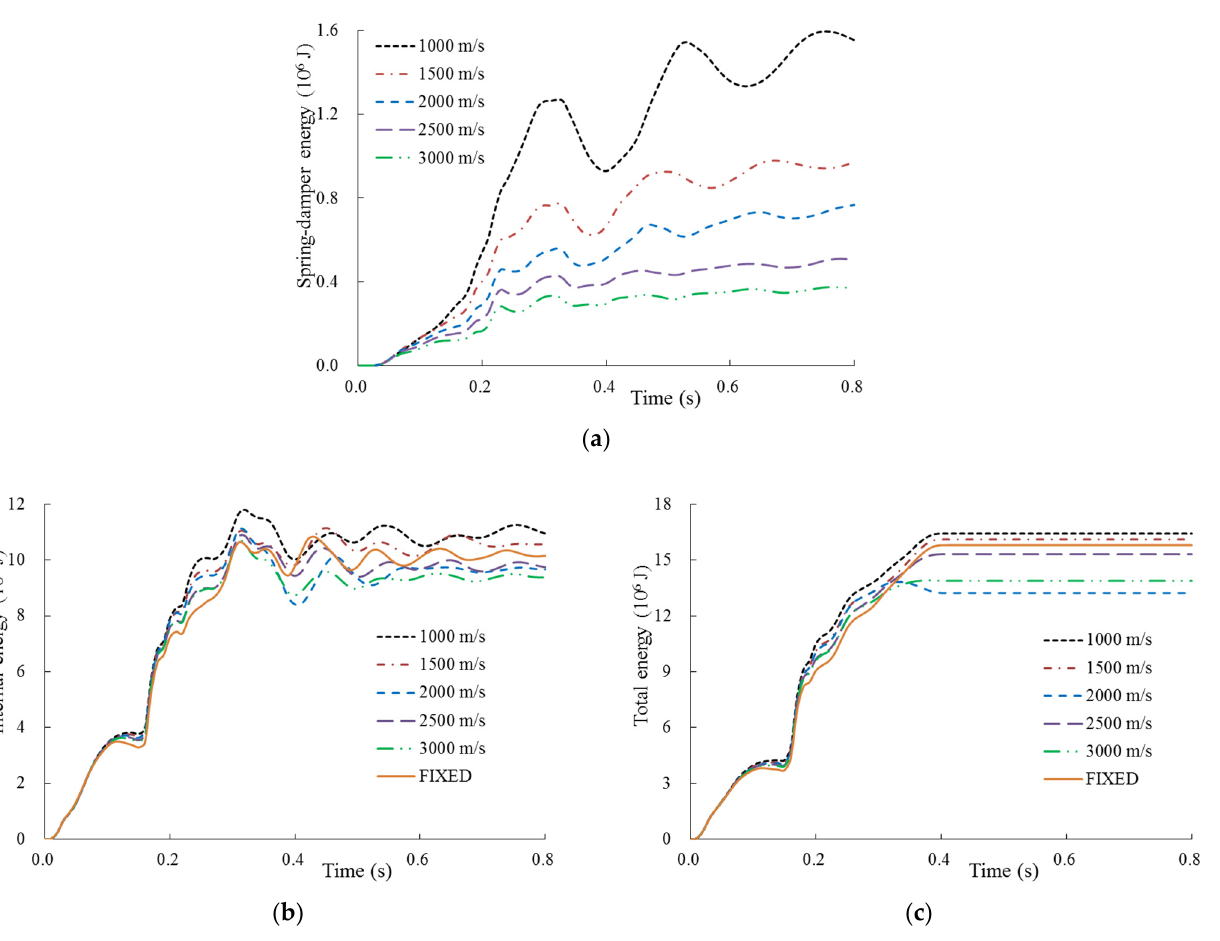
Figure 8. The spring-damper energy, internal energy, and total energy of containment for different site conditions. ( a ) Spring-damper energy. ( b ) Internal energy. ( c ) Total energy.